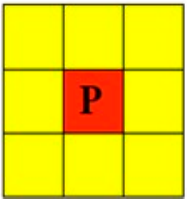
Figure 1. An eight-neighborhood system.